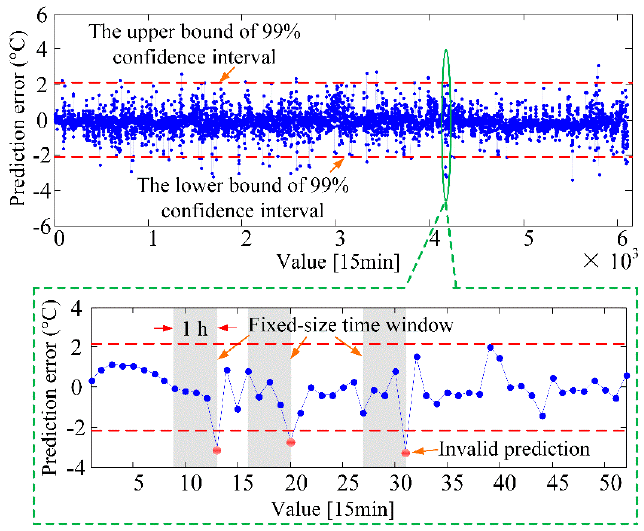
Figure 12. Collection of the prediction error series for gearbox input shaft temperature by using a fixed ‐ size time window.